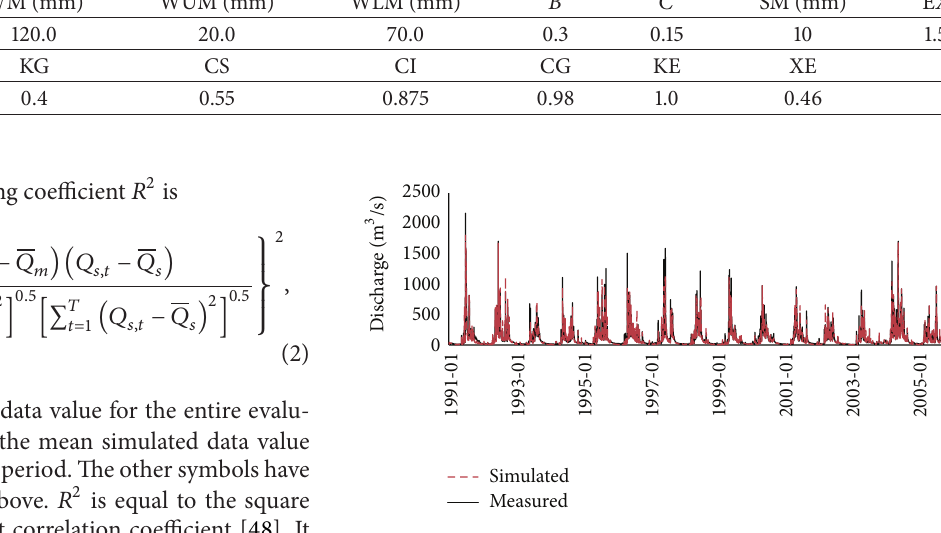
Figure 4: XAJ model simulation phase (1991 to 2005).